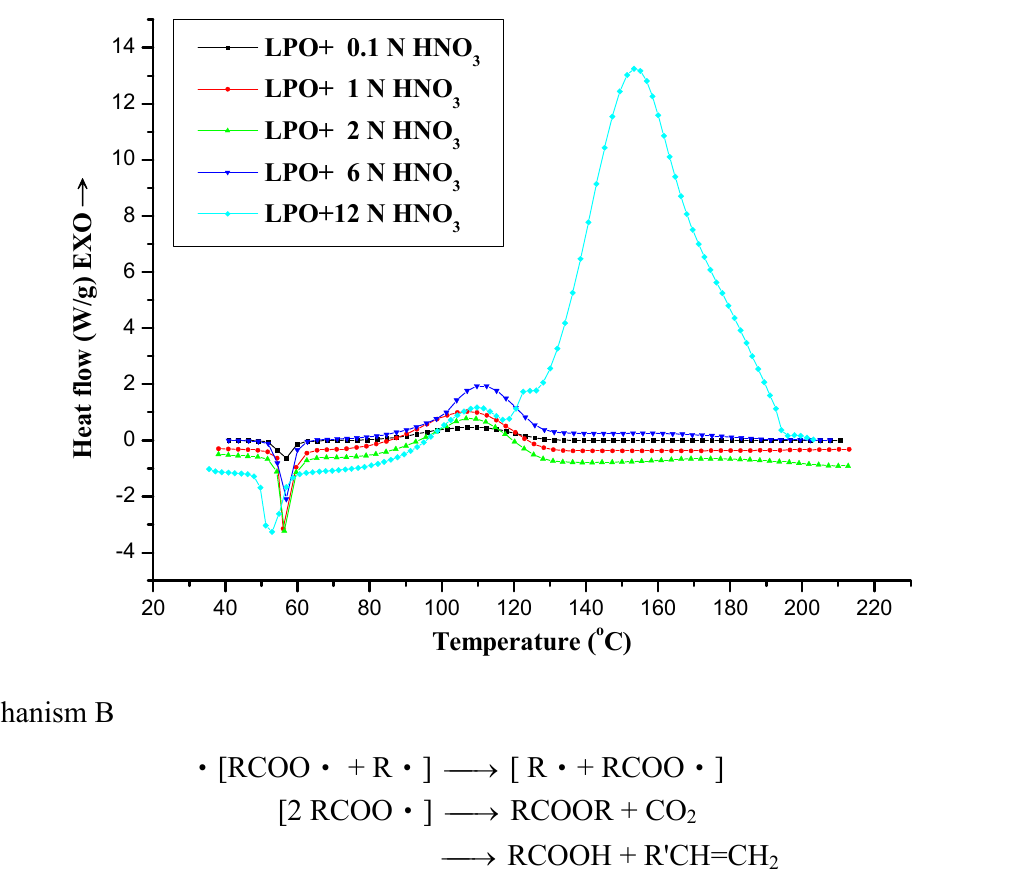
Figure 1. Heat flow vs. temperature by the DSC experiments for LPO 95 mass% mixed with 0.1, 1, 2, 6, and 12 N HNO 3